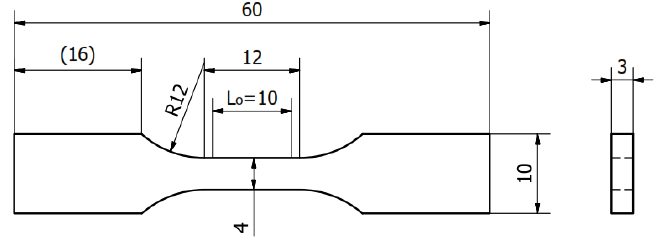
Figure 1. Dimensions in mm of the test specimens for determining mechanical properties under static tension in accordance with EN ISO 527-1.